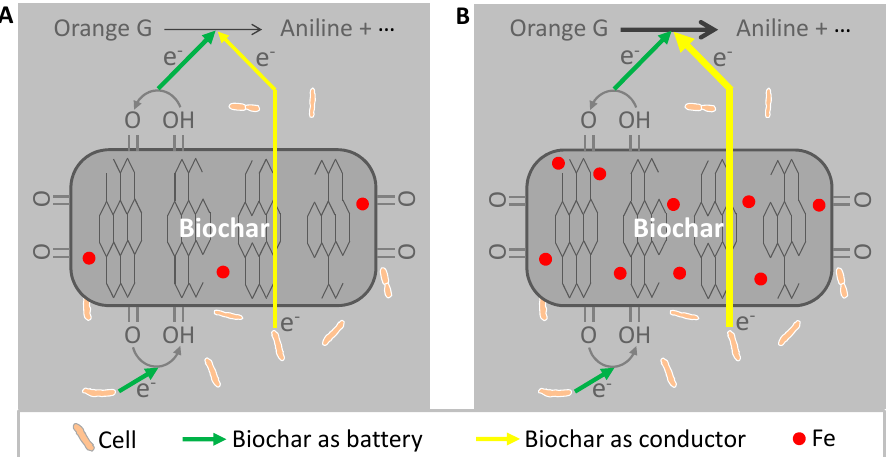
Figure 6. Schematic diagram of the biochar internal pathways for electron transfer in microbial reduction of Orange G to aniline mediated by biochars prepared using peanut stalks from the plot without Fe addition ( A ) and from the plot with Fe addition ( B ). Green arrows represent the charging and discharging cycles of the biochar battery mechanism, and yellow arrows represent the biochar conductor mechanism in which electrons transfer directly through conductive